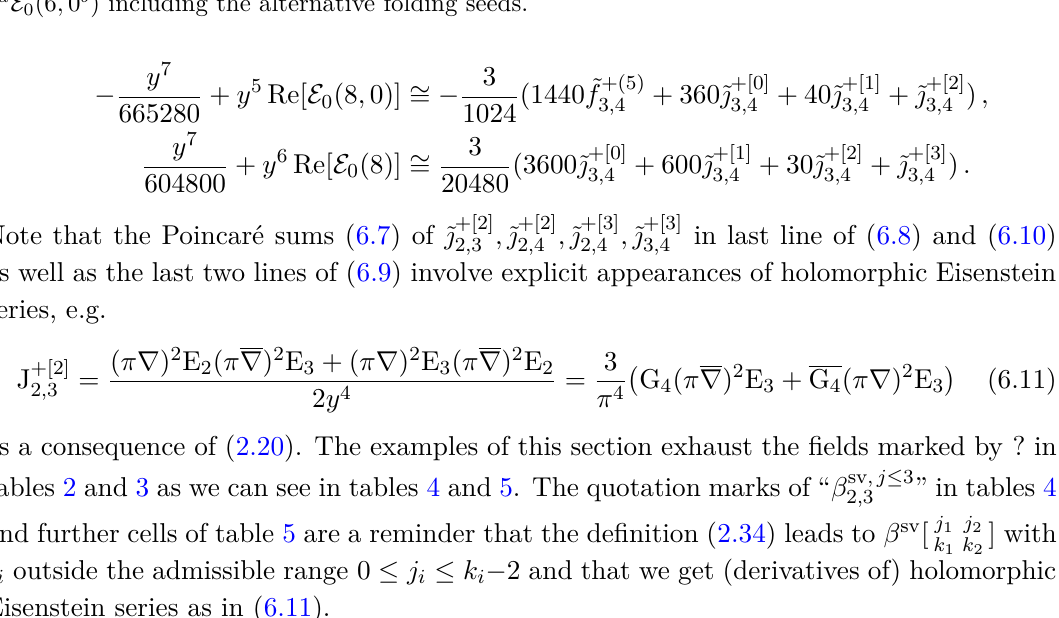
, or alternatively β sv ,j , obtained from Poincaré sums over 3 ,k k, 3